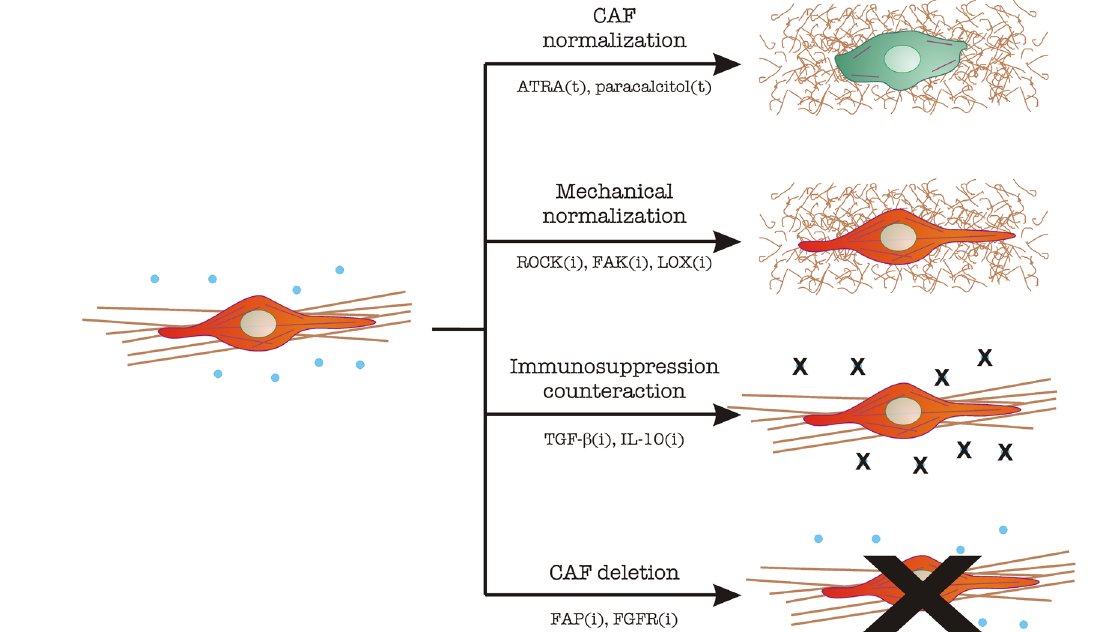
Figure 3. CAF targeting in tumor therapy. Image depicts the main mechanisms described under section “ Clinical approaches to normalize the mechanical alterations and immunosuppression induced by the fibroblast-to-CAF transition”. CAFs are represented in red, with a straight and bundled matrix underneath. Immunosuppressive cytokines (TGF-β, IL-10) are shown as blue dots. Normal fibroblasts are represented in green, with fewer cytoskeletal filaments and a thin, curled matrix underneath. Strategies include CAF normalization, mechanical normalization, counteracting immunosuppression, and CAF inhibition/elimination. The main molecular players in each strategy are indicated. The letter “t” denotes treatment with the indicated molecule.